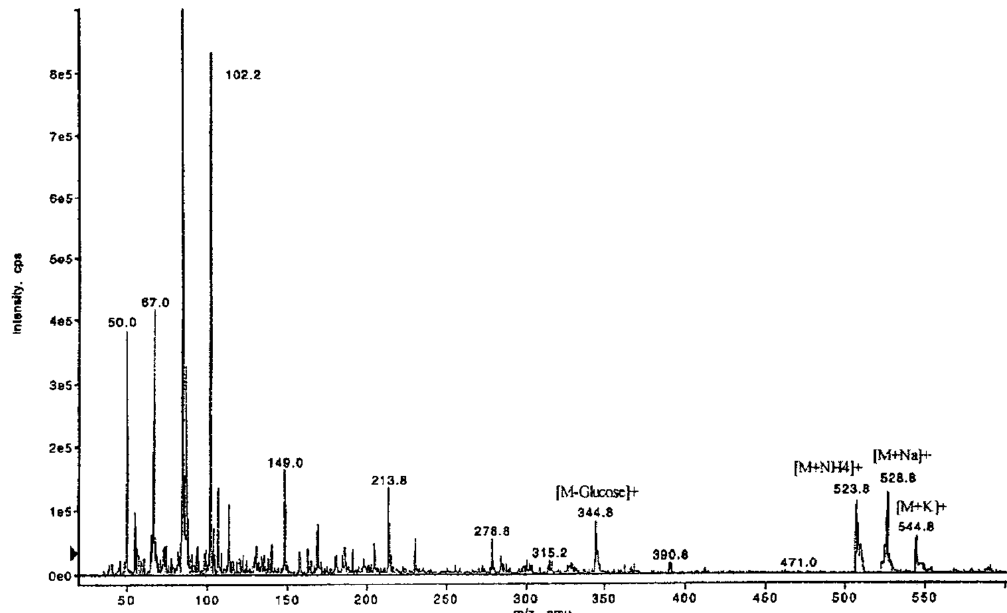
Molecules 2021 , 26 , x FOR PEER REVIEW